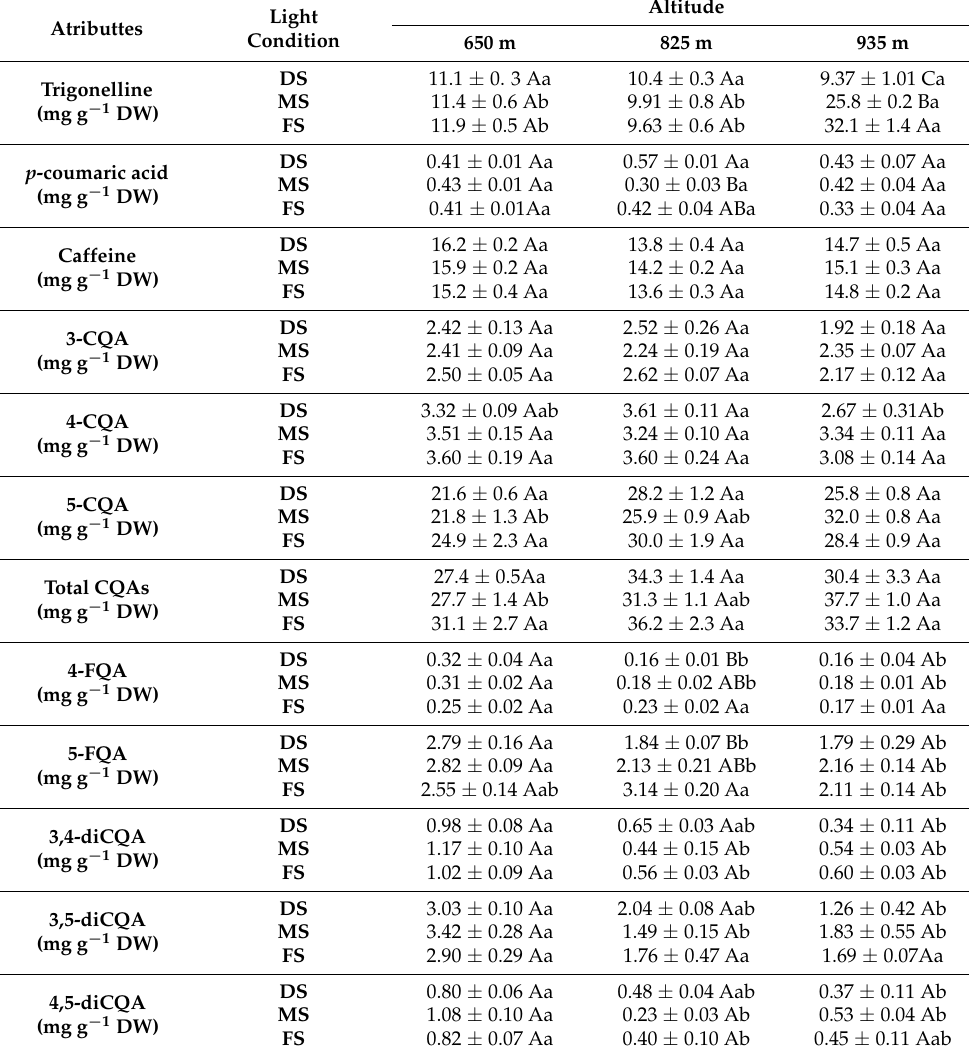
Mean values ± SE (n = 5) followed by the same letter comparing light conditions within each altitude (A, B, C) or altitude treatments within each light condition (a, b) are not significantly different according to the Tukey’s